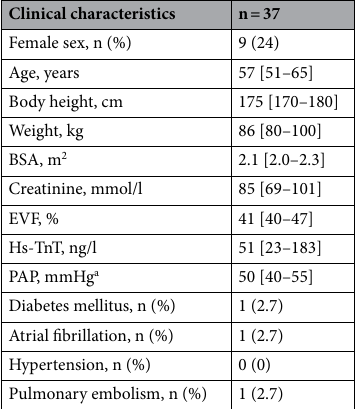
Table 1. Clinical characteristics of patients. Clinical characteristics presented as median (IQR) or absolute number (%). BSA body surface area, EVF erythrocyte volume fraction, Hs-TnT high-sensitive troponin T, PAP pulmonary artery pressure. a Data missing for n =